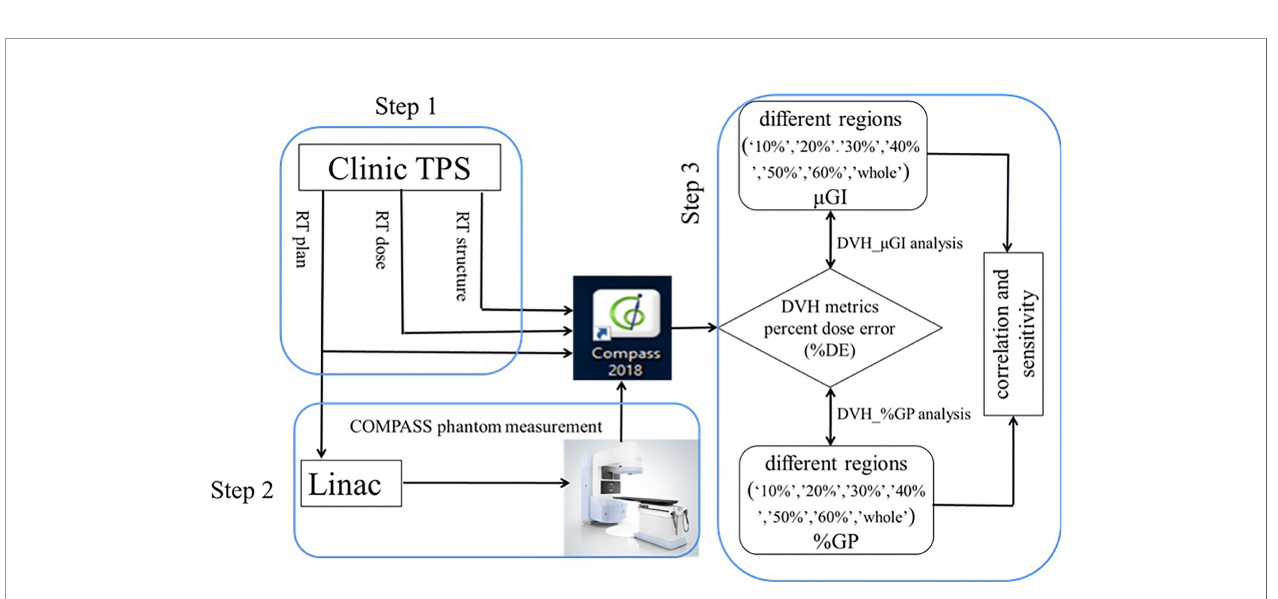
FIGURE 3 | Flowchart of the quality assurance process in the study.